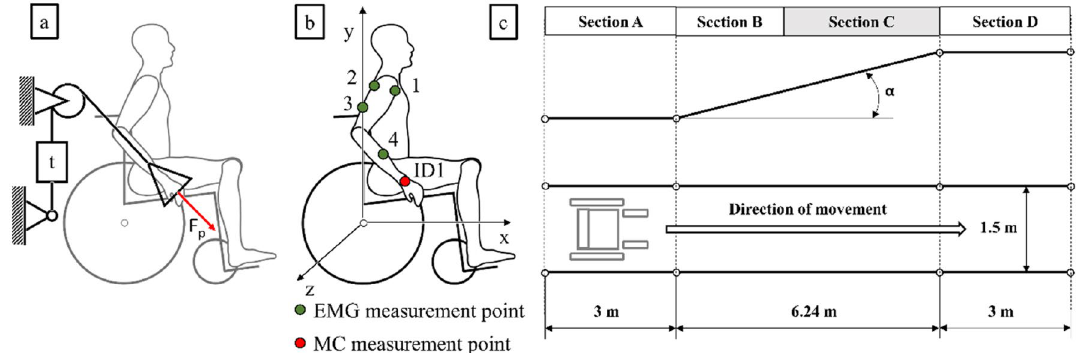
Figure 4. Schematic illustration of the push force measurement system ( a ), location of the motion capture and EMG measurement points ( b ), and the ramp used to perform the test ( c ). In this diagram: t—strain gauge force sensor, F p —push force, section A—the section used for wheelchair acceleration, section B—the section for which the measurement results were disregarded, section C—the section for which the measurement results were taken into account, section D—the final section where the wheelchair was stopped, α – the ramp inclination.